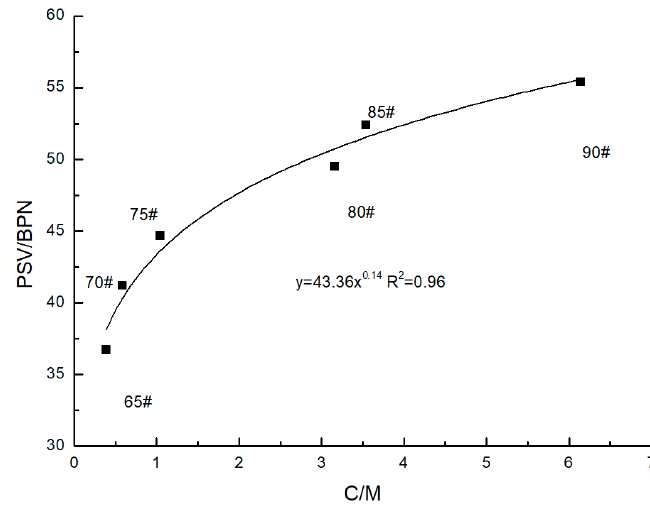
Figure 14. The relation between C/M and PSV.